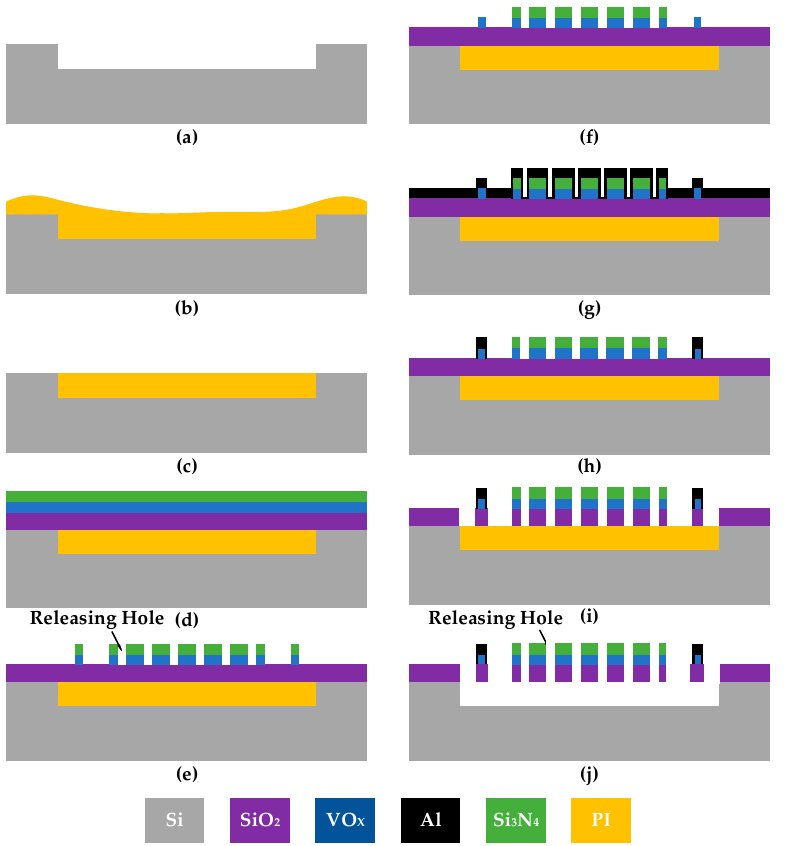
Figure 5. Fabrication flow diagram of VOx Pirani gauge. ( a ) Cavity Etch. ( b ) PI coating and curing. ( c ) CMP flattening. ( d ) SiO 2 , VOx, Si 3 N 4 thin film deposition. ( e ) VOx and Si3N4 etching. ( f ) Electrode Window Etch. ( g ) Al thin film deposition. ( h ) Al Electrode Etch. ( i ) PI Release Window Etch. ( j ) PI Release.